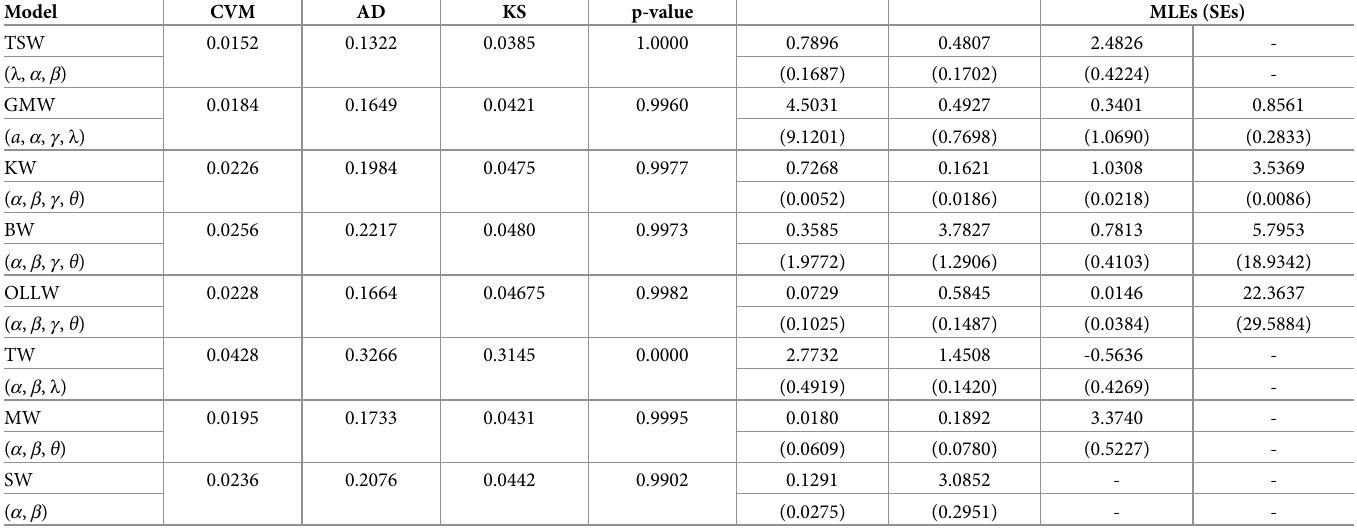
Table 2. CVM, AD, KS with p-value, MLEs and SEs for the first data set.